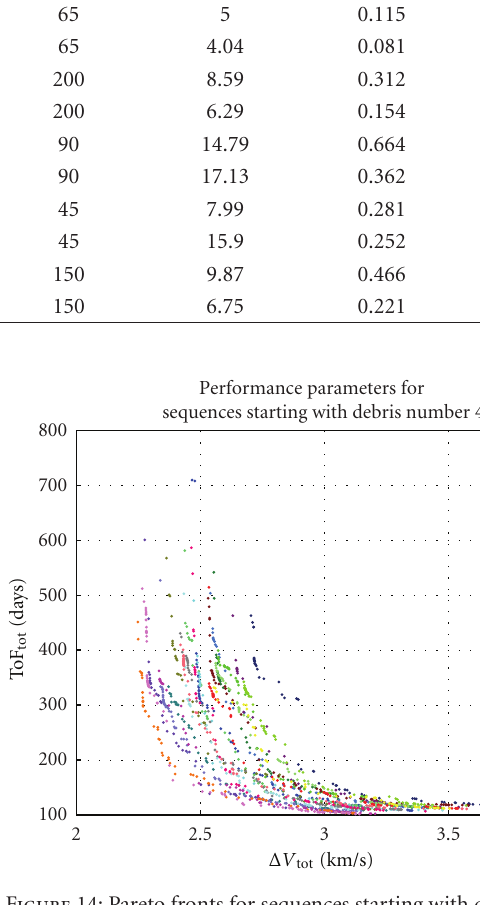
Figure 13: Pareto fronts for sequences starting with debris nr. 3. Figure 14: Pareto fronts for sequences starting with debris nr.